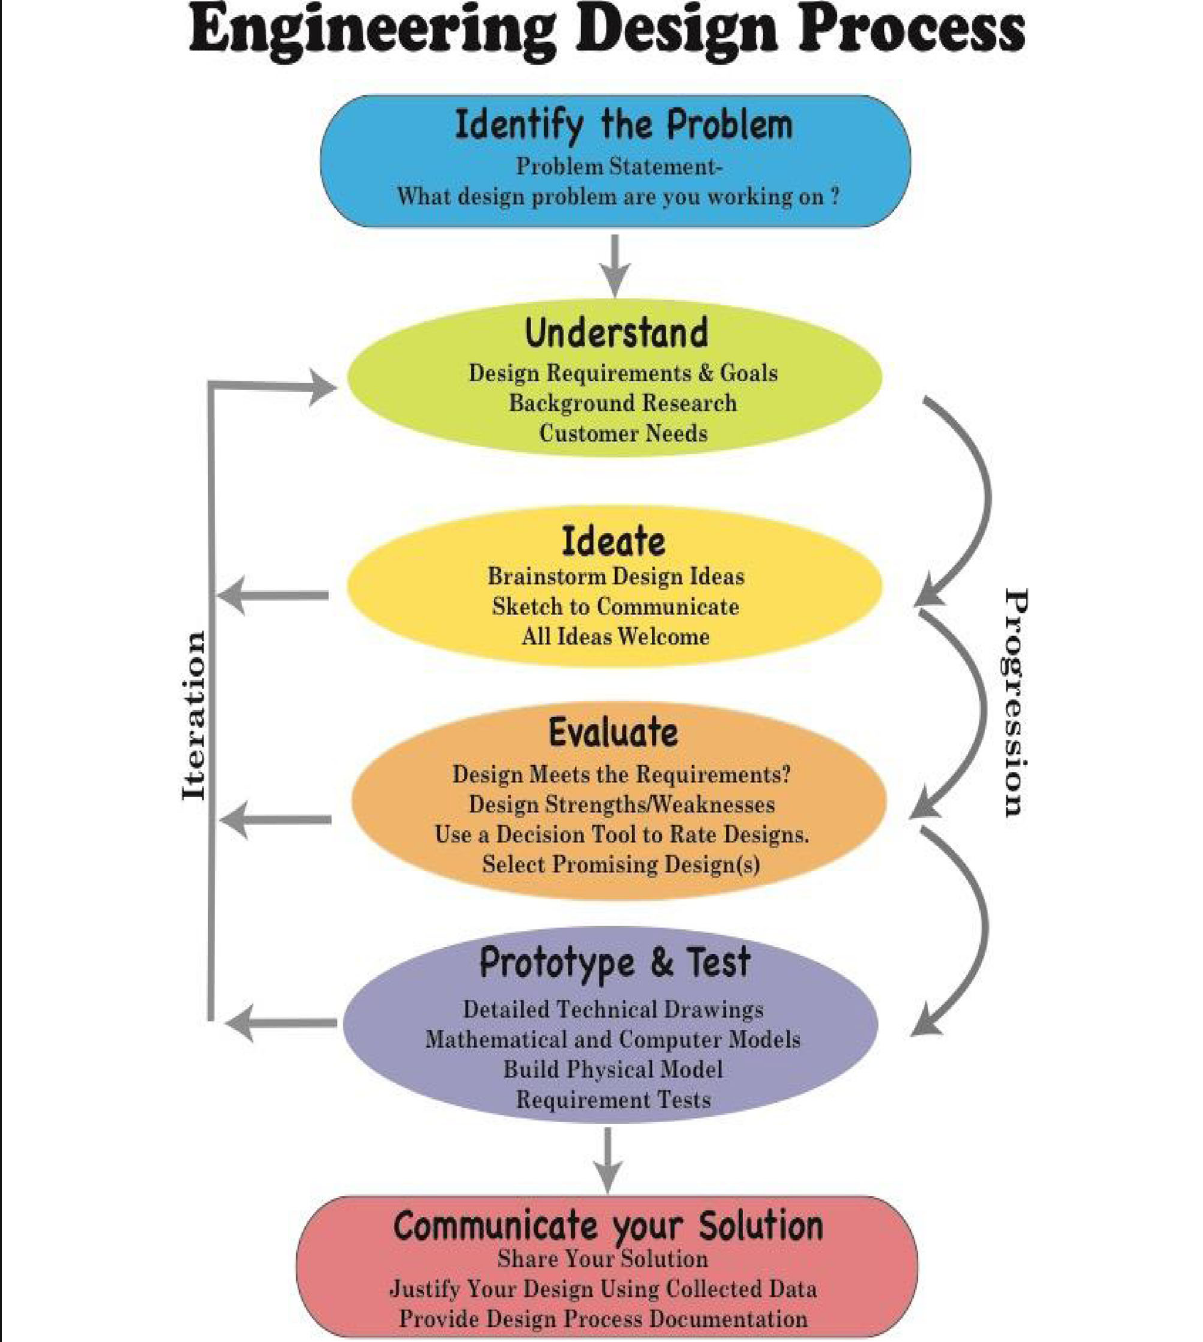
Fig. 1 Conceptual model for the engineering design process. This figure is the representation of the engineering design process included in the curriculum used to instruct the students who participated in this